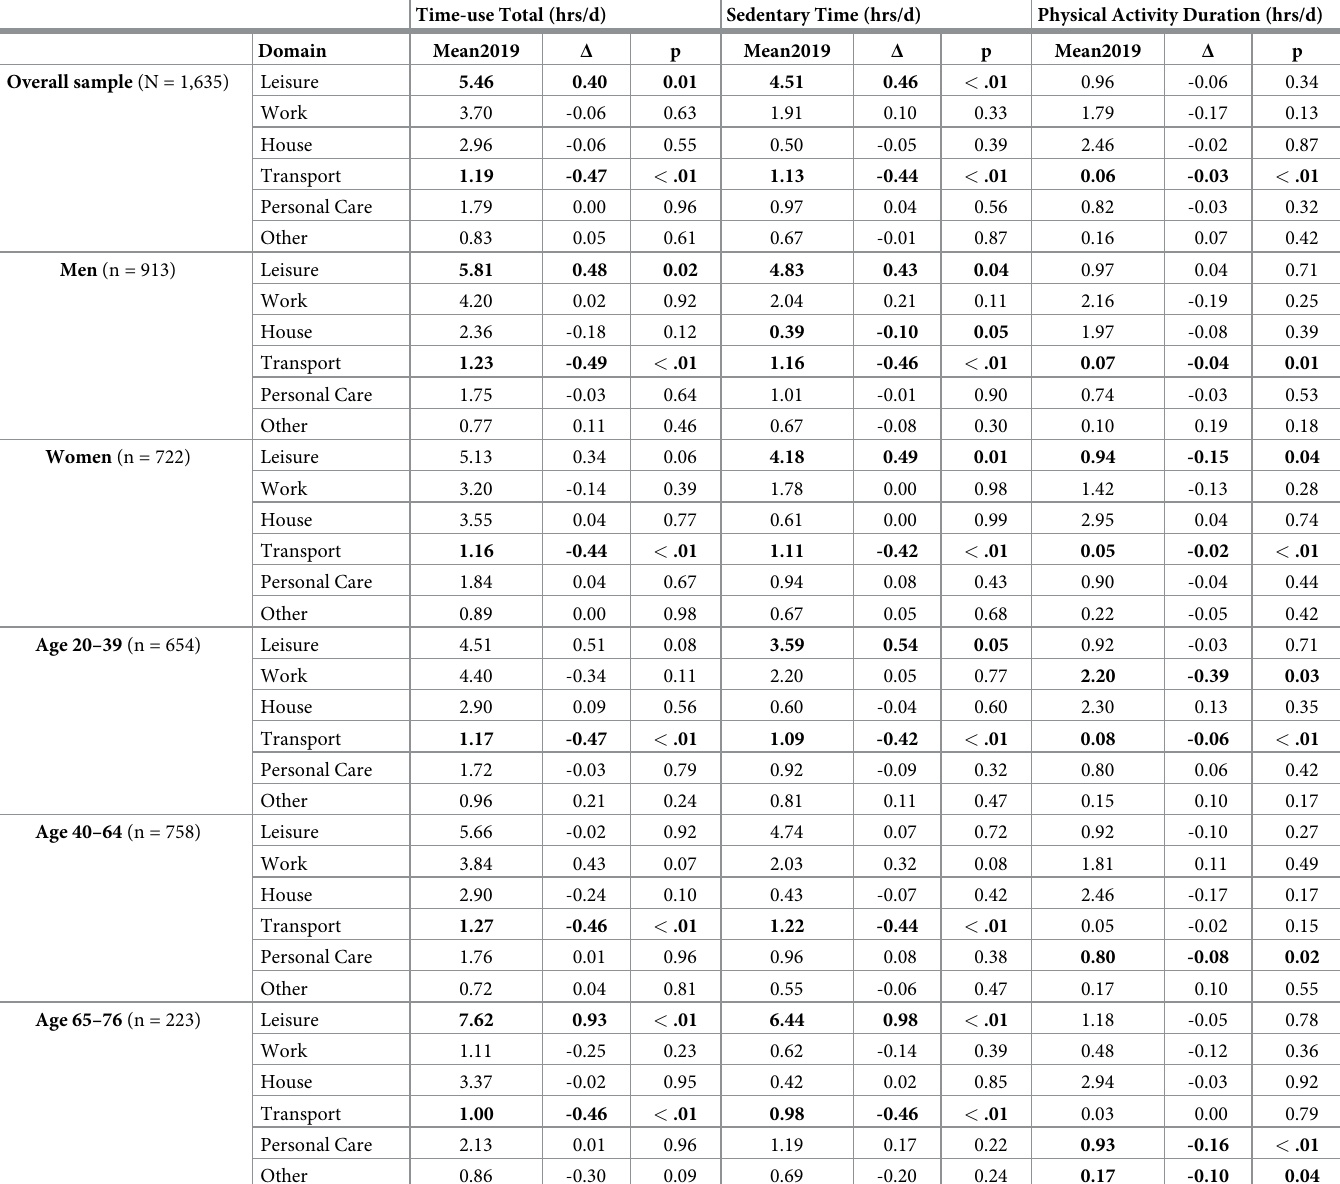
Table 3. Changes ( Δ ) in total time-use, sedentary time, and physical activity pre-pandemic in Fall 2019 and Fall 2020, overall and by sex and age-group—US